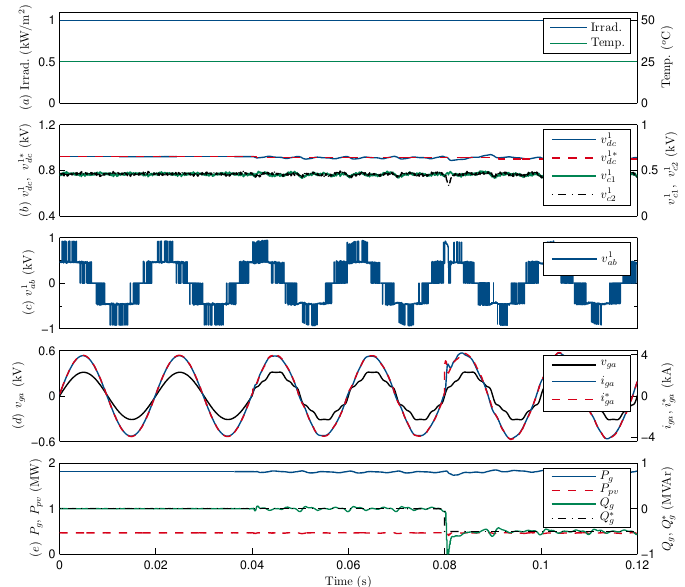
Figure 14. Steady-state results operating at STC conditions under distorted grid: ( a ) Irradiance and temperature levels; ( b ) capacitor and dc-link voltages; ( c ) converter output voltage; ( d ) voltage and current grid with its reference; ( e ) active and reactive with their references.